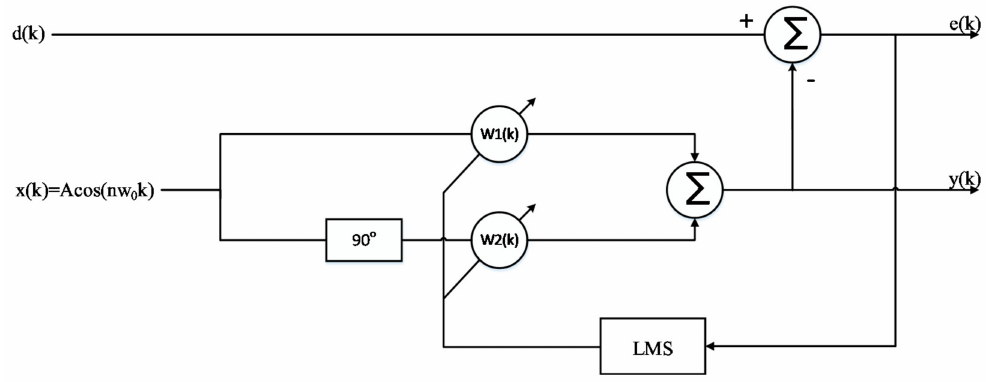
Figure 10. Single frequency adaptive notch filter based on the least mean square